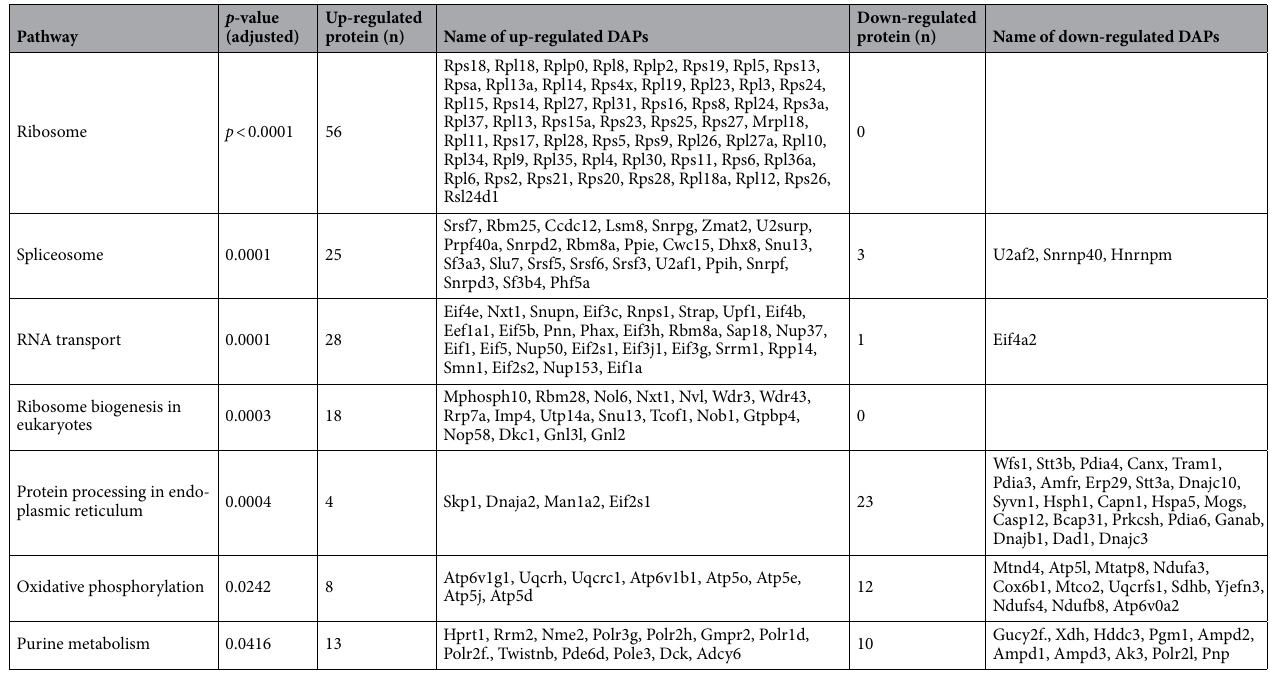
Table 2. KEGG pathway enrichment result.